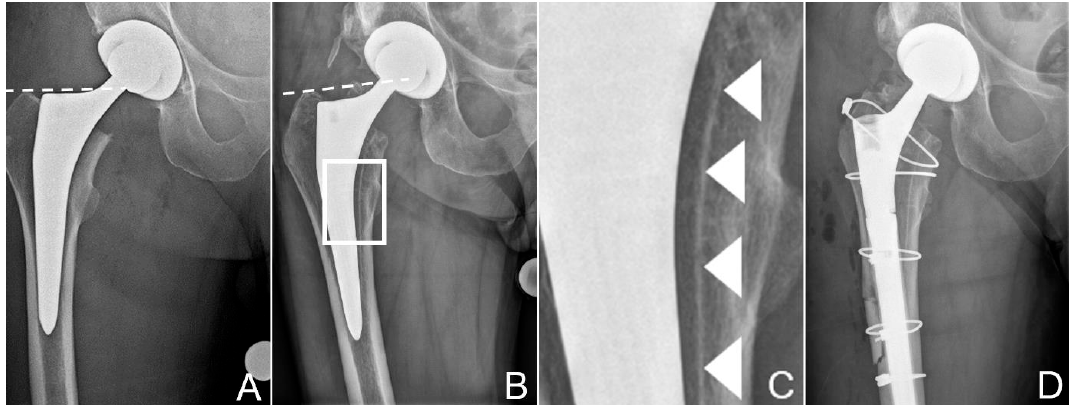
Figure 1. Zone of interest of the anteroposterior radiographies of the pelvis after total hip replacement ( A ) and after the patient had suffered the periprosthetic fracture of the proximal femur ( B ). Dashed lines at the tip of the greater trochanter help identify posttraumatic sintering of the stem. Note that the stem was undersized, with more than 1 mm between the stem and the inner cortex. Scale-up of ( B ), marked by a white rectangle, is provided in ( C ) to better illustrate the dense line, most likely the hydroxyapatite (HA) coating, separated from the stem, marked by white arrowheads. These tissues could be sampled for further analysis. ( D ) shows the condition after revision. The osteotomy, which was necessary to retrieve the stem, is visible, as are the cerclage cables used for fixation of the fracture and the osteotomy. Additionally, note the thinner liner in the cup, to accommodate the larger head. Microbiological samples and routine histopathological analysis showed no signs of